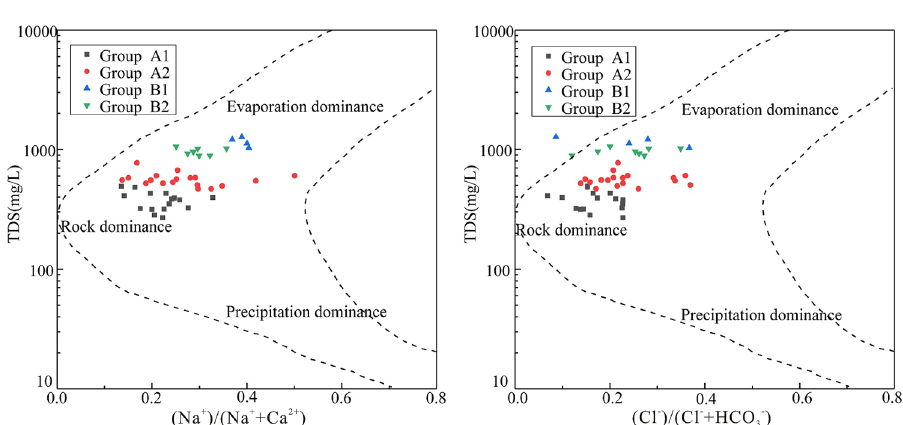
Figure 7. Gibbs diagrams of the water groups defined by